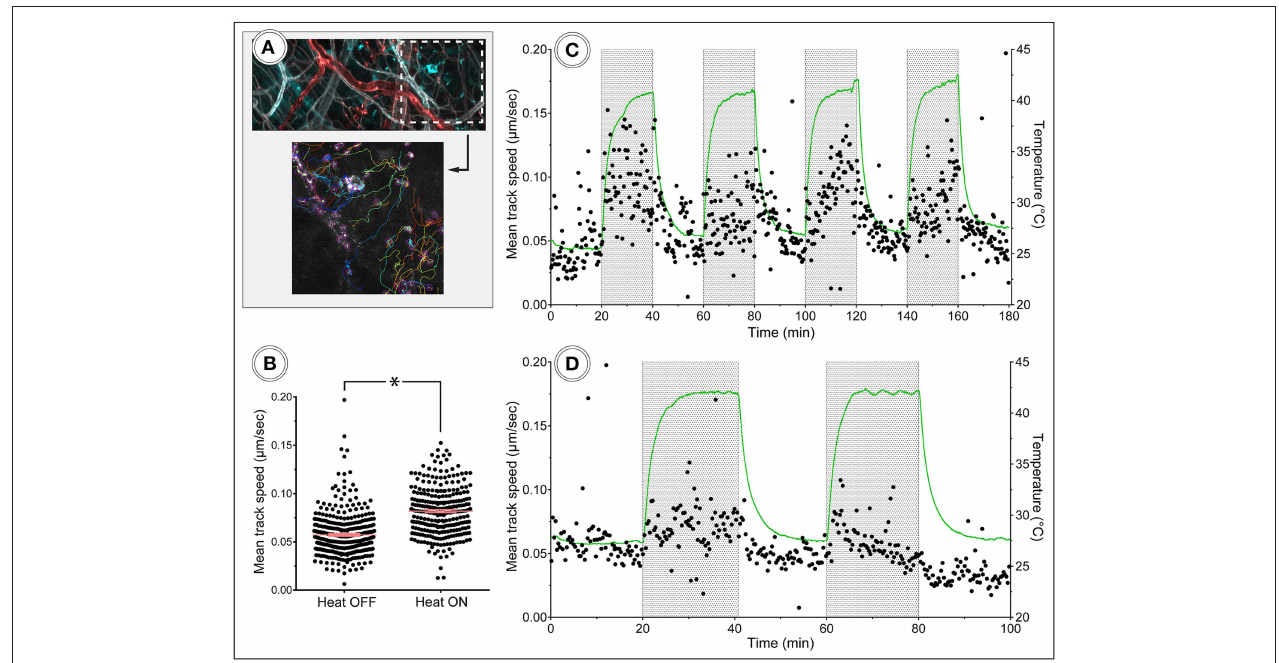
FIGURE 9 | In vivo tracking of leukocyte migration during heat challenge. (A) Shows a frame from the corresponding time-lapse movie and tracking data. Color code: Ly6G–cyan, CD31–gray, NG2–red. (B) Migration speed of neutrophils was increased during heating periods compared to periods without heating. (C,D) Show track speed of neutrophils and CX 3 CR1 positive cells, respectively, plotted over time with heating periods indicated by gray